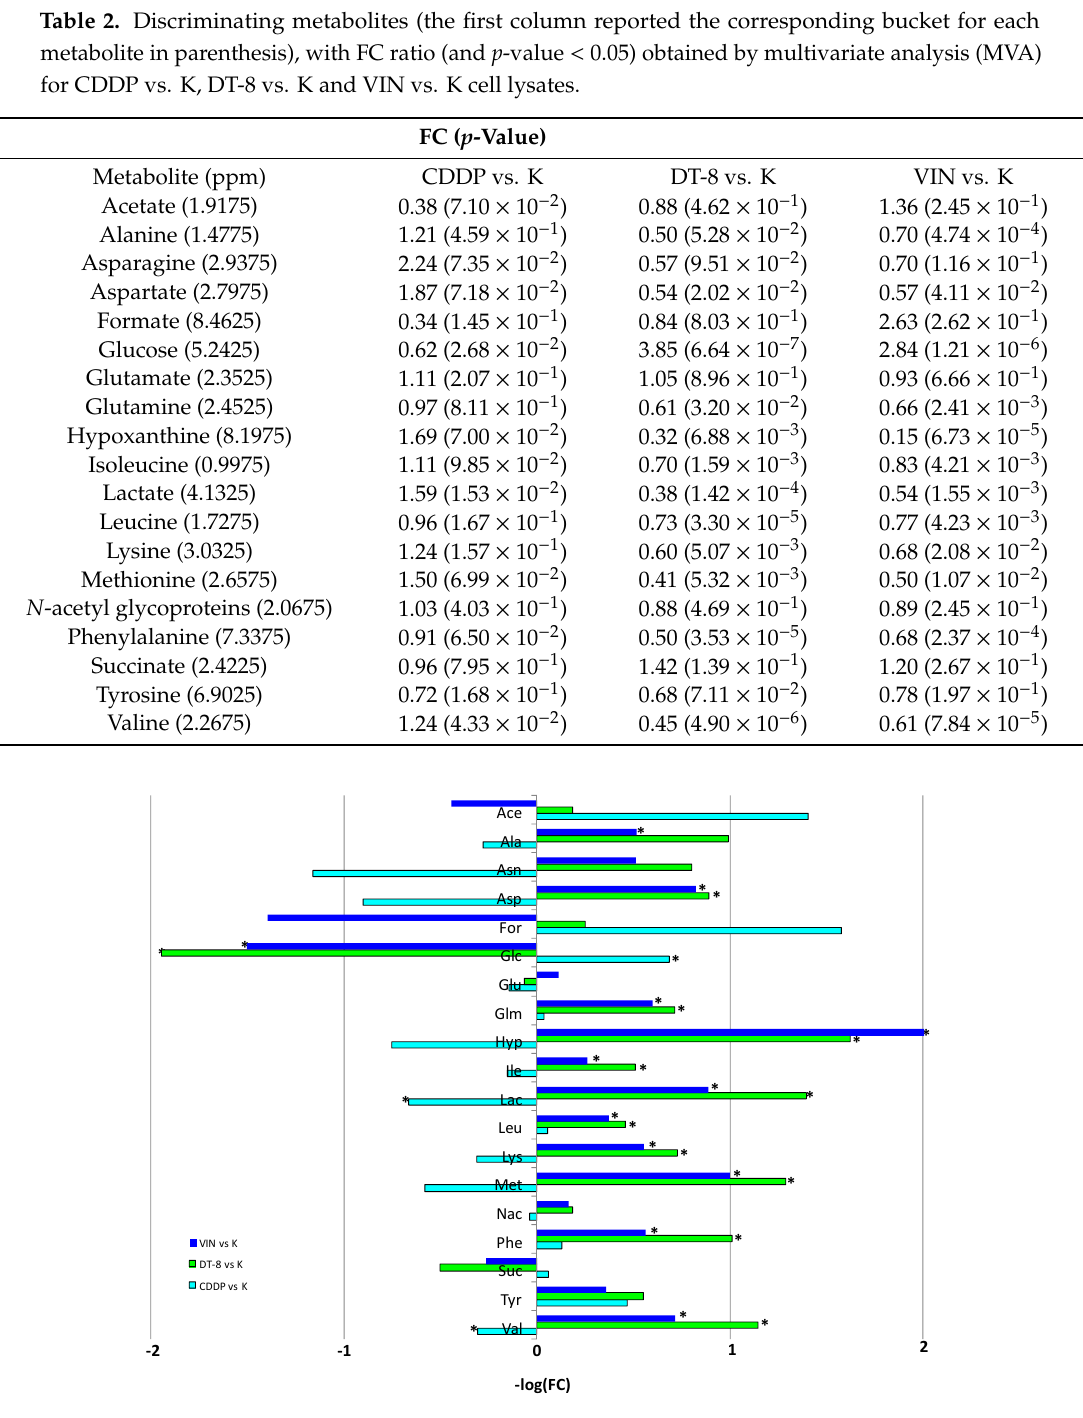
Figure 5. Discriminant metabolite comparison between treated samples (A: CDDP, B: DT-8 and C: VIN) and the controls (K). * The values of metabolites having Log 2 (FC) with p -value < 0.05 (x axis). (Ace: acetate; Ala: alanine; Asn: asparagine; Asp: aspartate; For: formate; Glc: glucose; Glu: